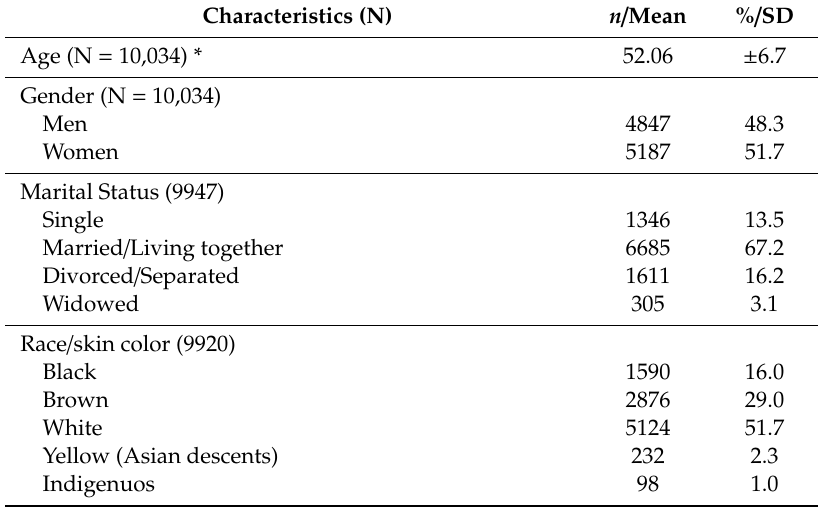
Table 1. Sociodemographic characteristics of working population in the ELSA-Brasil study,